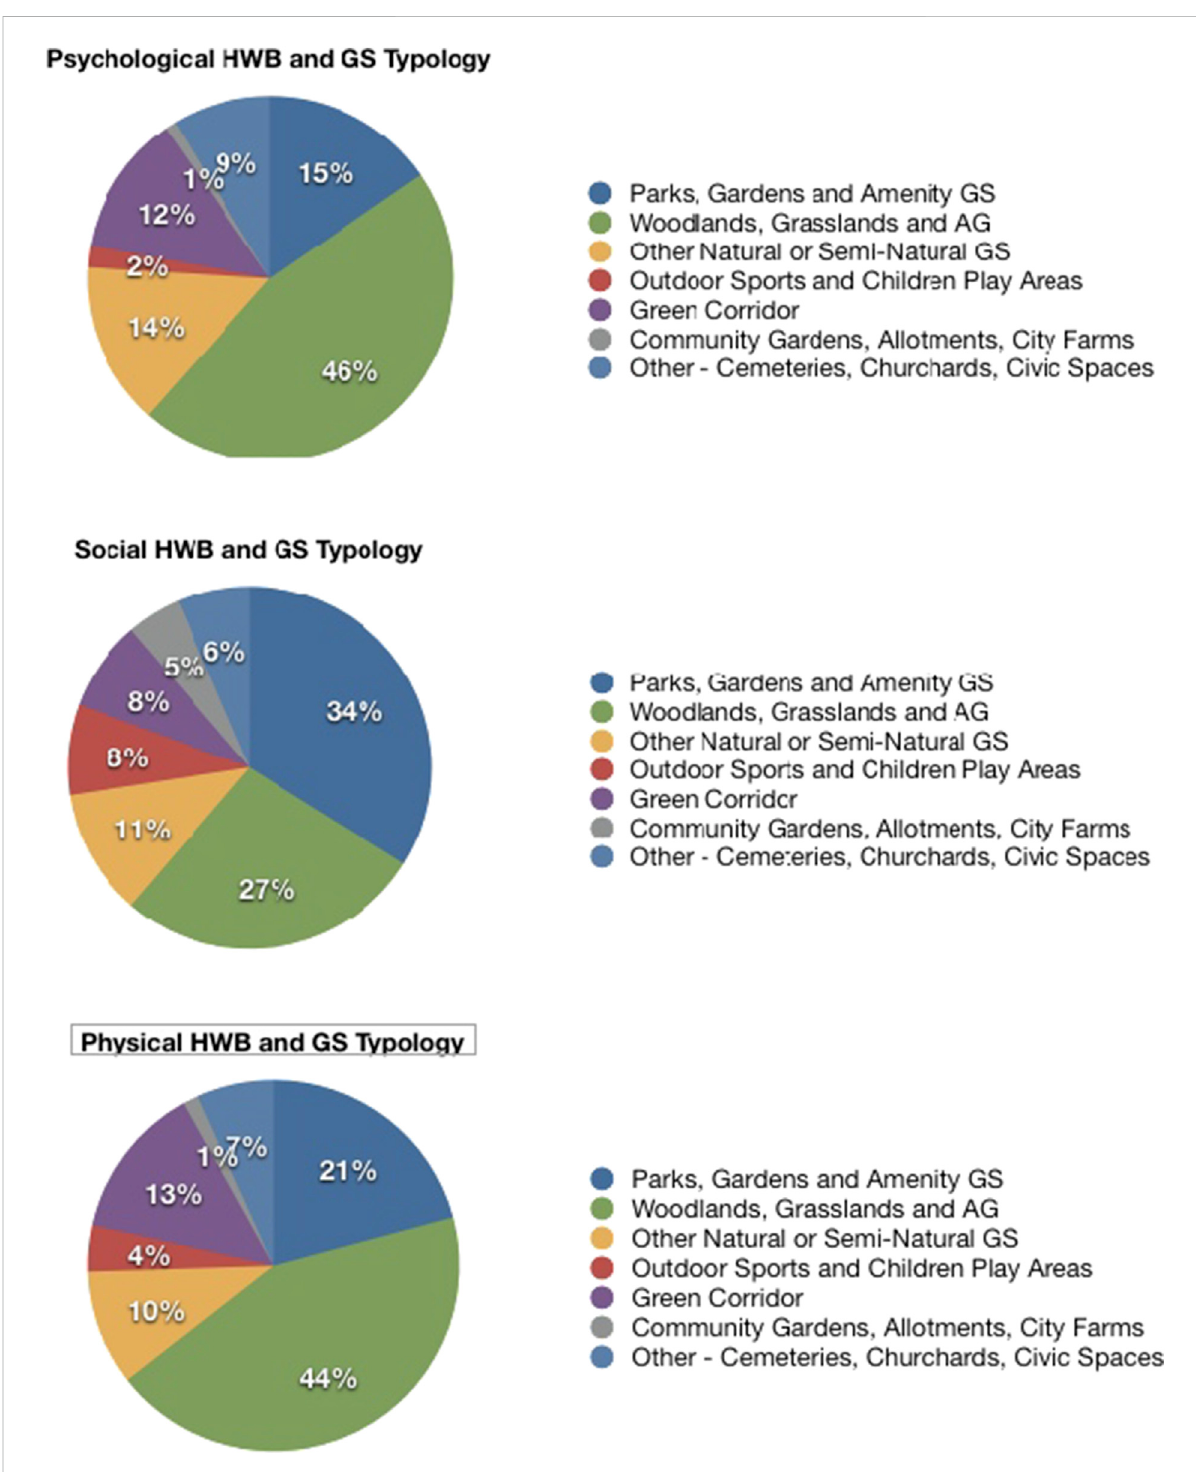
FIGURE 8 Human wellbeing affordance locations and urban greenspace typologies. Source: